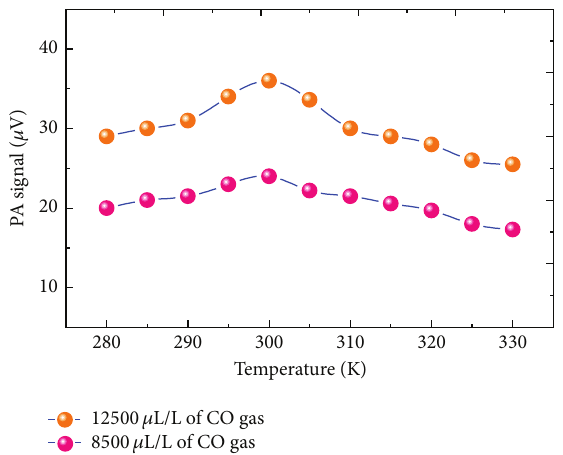
Figure 7: The PA signal versus operating temperature ranging from 280 to 330